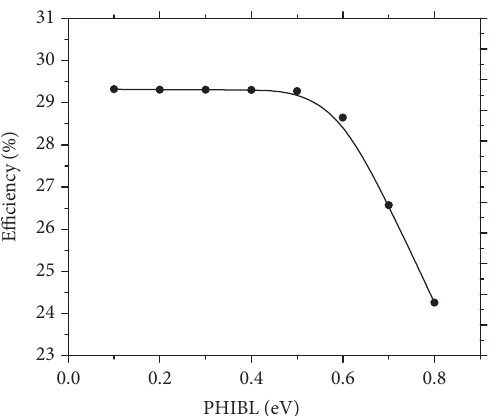
Figure 9: PHIBL versus Voc plot of the proposed solar cell ’ s back contact.